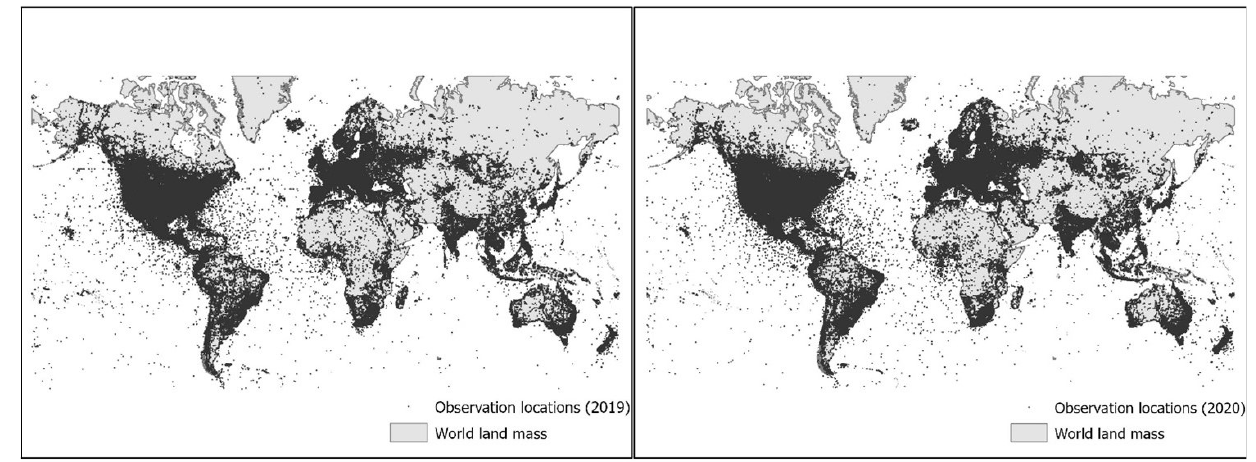
Figure 1. iNaturalist observation locations in 2019 ( left ) and 2020 ( right ).